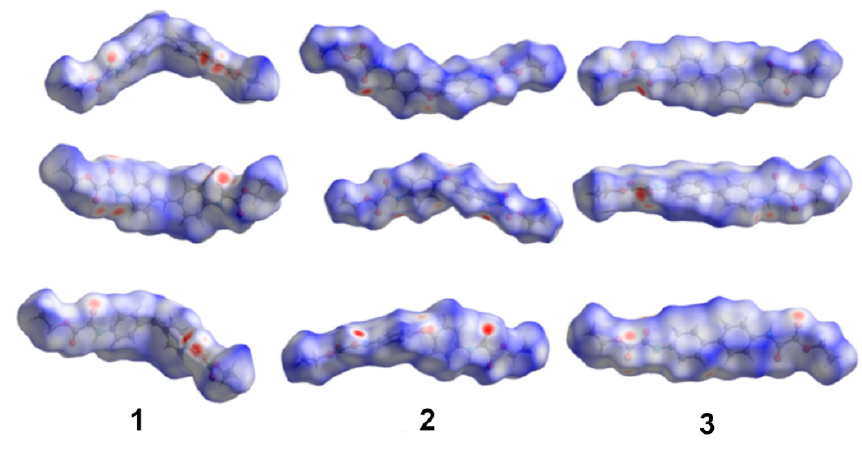
Figure 10. Hirshfeld surfaces from different perspectives for crystal structures 1 - 3.